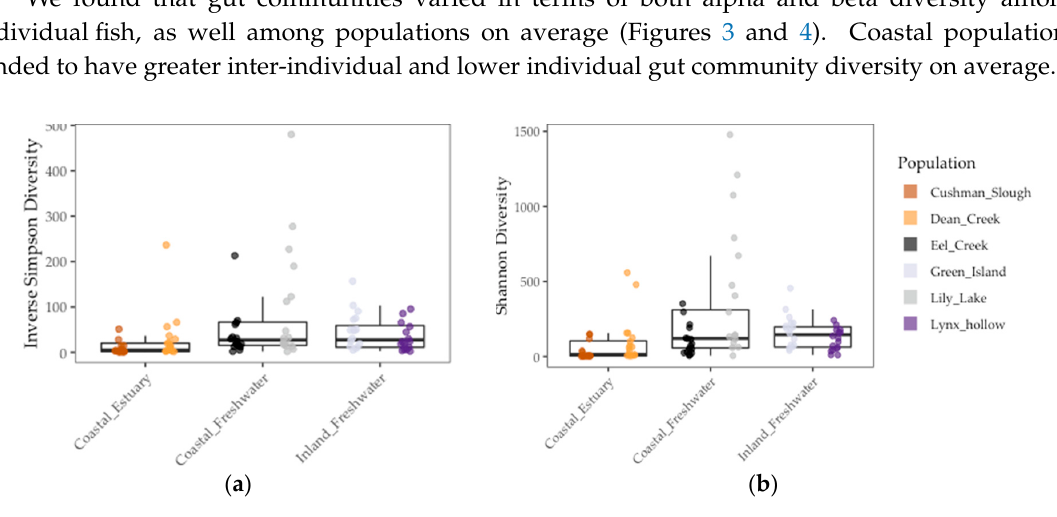
Figure 3. Gut microbiome alpha diversity among threespine stickleback populations in Oregon in terms of inverse Simpson diversity ( a ) and Shannon diversity ( b ) measures. Colors represent collection sites (“populations”). Each point is a fish gut. Mid-box lines are pooled means of major environments (e.g., Coastal Freshwater”). Box whiskers are pooled standard deviation of major environments, as well.